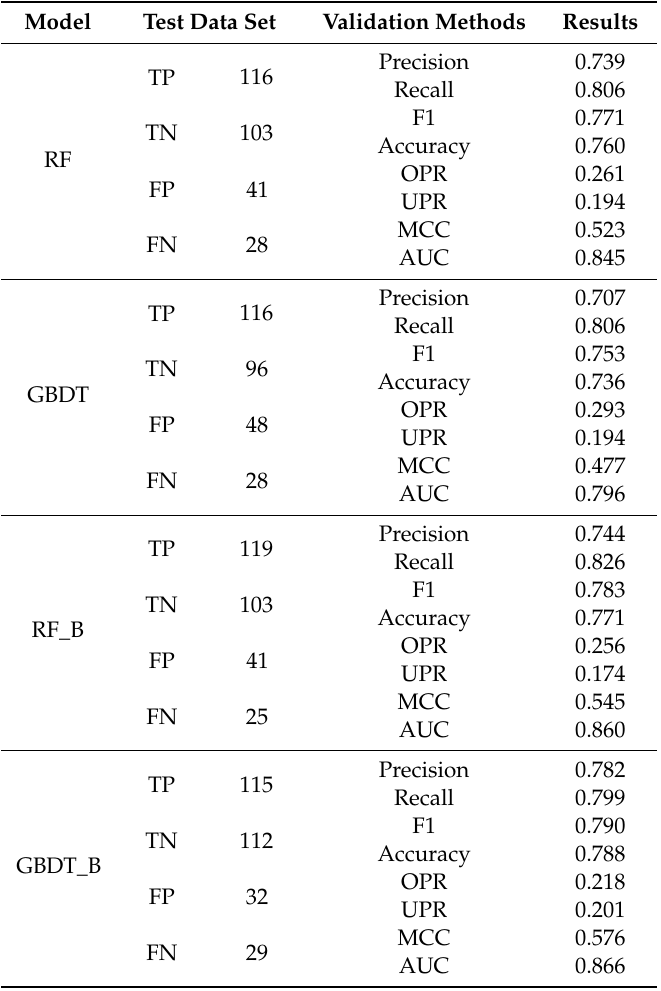
Table 5. Model validation results using multiple